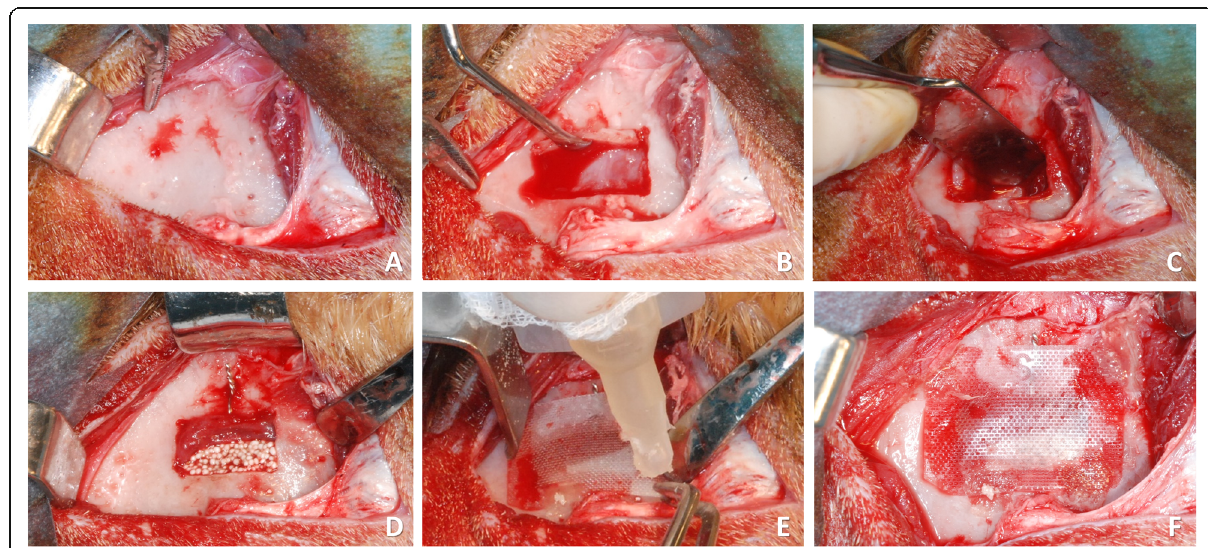
Fig. 1 Clinical view at a membrane site. a Skin and periosteum were separately elevated, and the facial sinus wall exposed. b A 12 × 8-mm window was cut and removed. c The Schneiderian membrane was carefully elevated. d A twisted wire was inserted in the middle of the long side of the window and the elevated sinus was grafted. e At the control site, a resorbable membrane was placed and secured with cyanoacrylate.